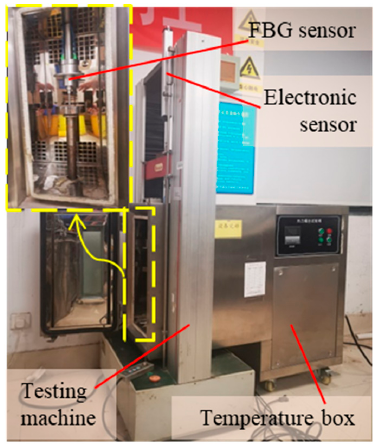
Figure 9. Thermal–displacement coupling test device.